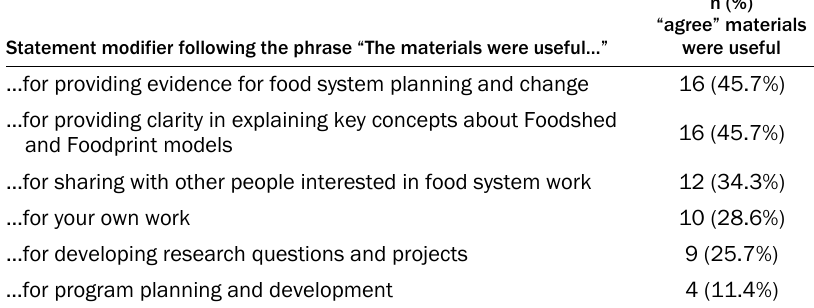
Table 7. Online Survey Responses Regarding the Usefulness of Workshop Materials ( N